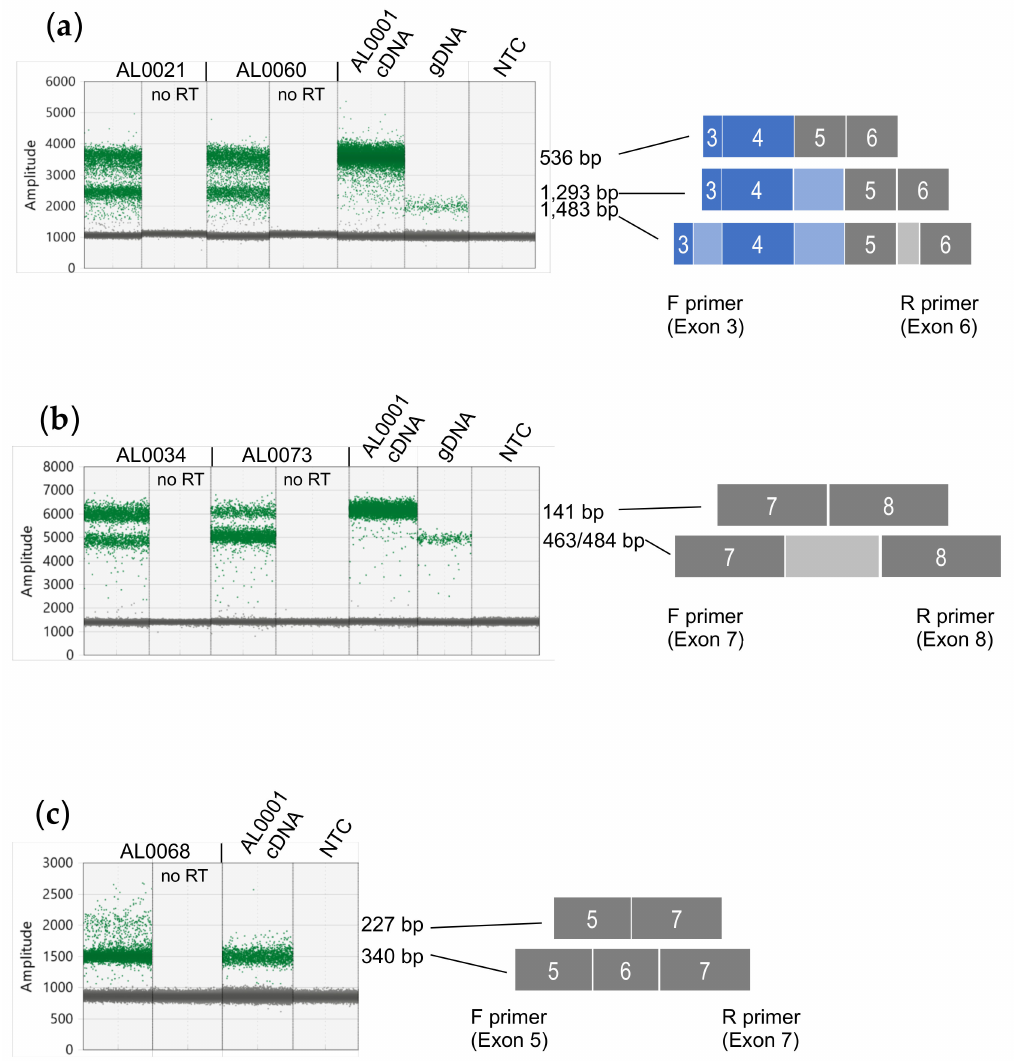
Figure 3. Validation of TP53 splicing mutations in breast cancer samples. ( a ) ddPCR assay between TP53 exons 3 and 6 showing amplification of TP53 transcripts. AL0021 and AL0060 have a point mutation in the TP53 intron 4 donor splice site at +1 and +5, respectively. AL0001 has no splicing mutations and was used as a control to show the fluorescence amplitude of a correctly spliced TP53 RNA (536 bp), whereas those TP53 RNAs retaining intron 4 have an amplicon size of 1293 bp. Genomic DNA (gDNA) was used as a control template to show an amplicon with retention of introns 3, 4 and 5. ( b ) ddPCR assay between TP53 exons 7 and 8 showing amplification of TP53 transcripts. AL0034 and AL0073 have a 21 bp deletion spanning the TP53 intron 7 donor splice site or a point mutation at +1 in the TP53 intron 7 donor splice site, respectively. AL0001 has no splicing mutations and was used as a control to show the fluorescence amplitude of a correctly spliced TP53 RNA (141 bp), whereas those TP53 RNAs retaining intron 7 have an amplicon size of 463 or 484 bp for AL0034 and AL0073, respectively. Genomic DNA (gDNA) was used as a control template to show an amplicon with retention of intron 7 (484 bp). ( c ) ddPCR assay between TP53 exons 5 and 7 showing amplification of TP53 transcripts. AL0068 has a point mutation at − 1 in the TP53 intron 5 acceptor splice site. AL0001 has no splicing mutations and was used as a control to show the fluorescence amplitude of a correctly spliced TP53 RNA (340 bp), whereas those TP53 RNAs skipping exon 6 have an amplicon size of 227 bp. ddPCR results shown are “1-D” plots, with green dots representing droplets where PCR products have been amplified and grey dots represent no amplified PCR product. The fluorescence amplitude (Amplitude) on the y-axes is indicative of amplicon size/s within each